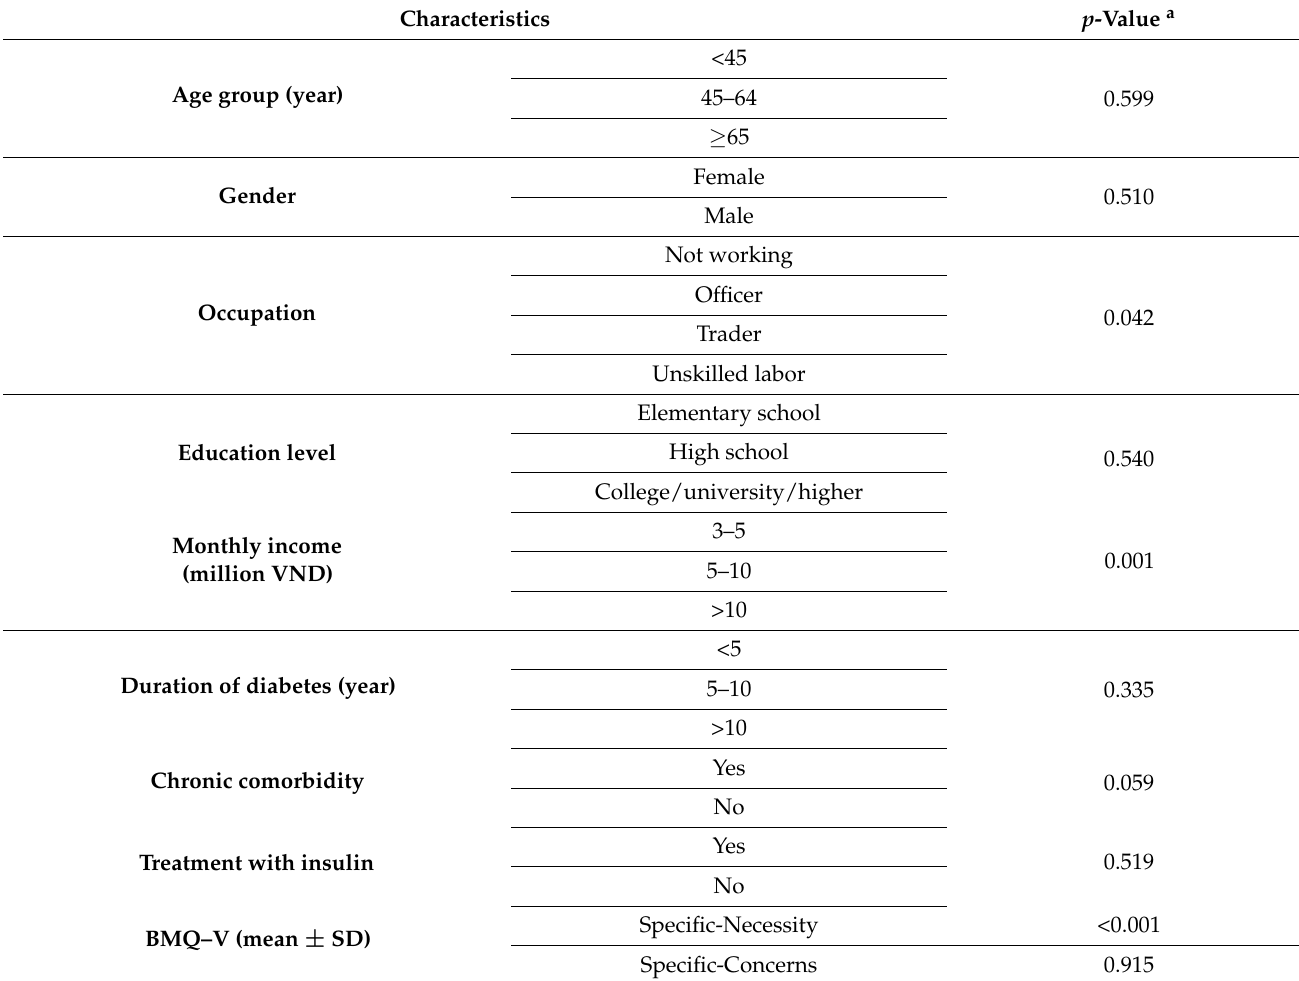
Table A4. The Relationship between Medication Adherence and Patients’ Characteristics (Five Levels of